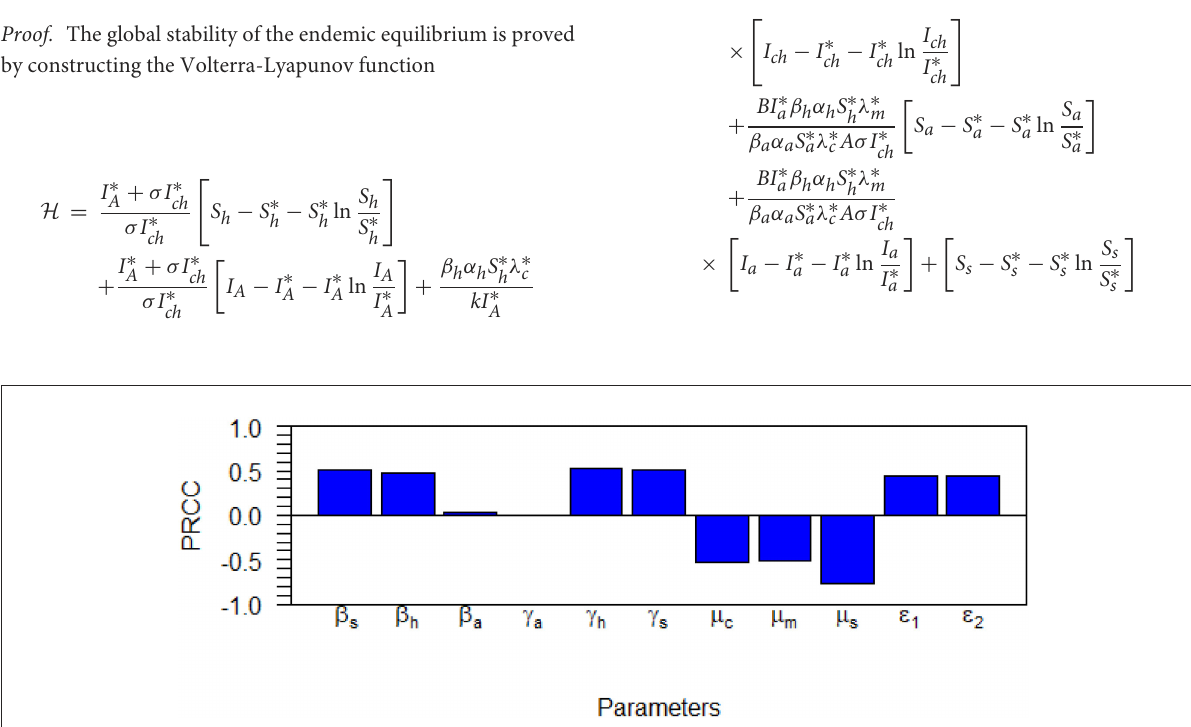
FIGURE3 Tornado plot for the dynamics of Schistosomiasis infection on the R 0 showing the model parameters with their PRCC values.